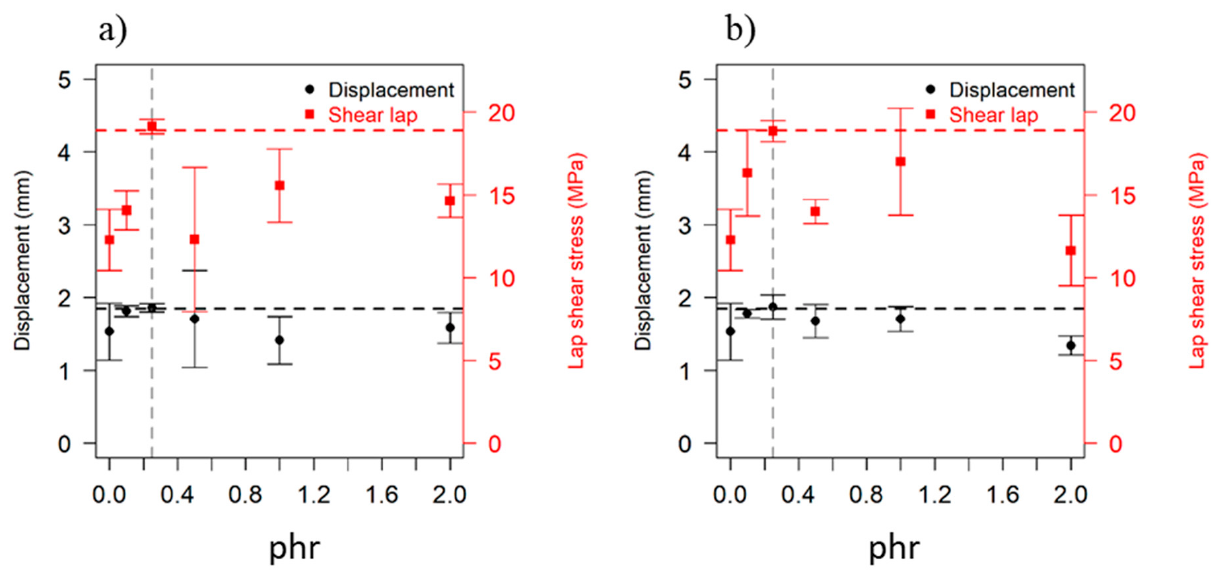
Figure 7. Lap shear strength of the IR-welded sample versus phr of each of the multifunctional methacrylate monomers: the red square points represent lap shear stress. The black circle points represent displacement during single-lap shear stress. ( a ) SLS test data with BDDMA and ( b ) SLS test data with TCDDMDA.